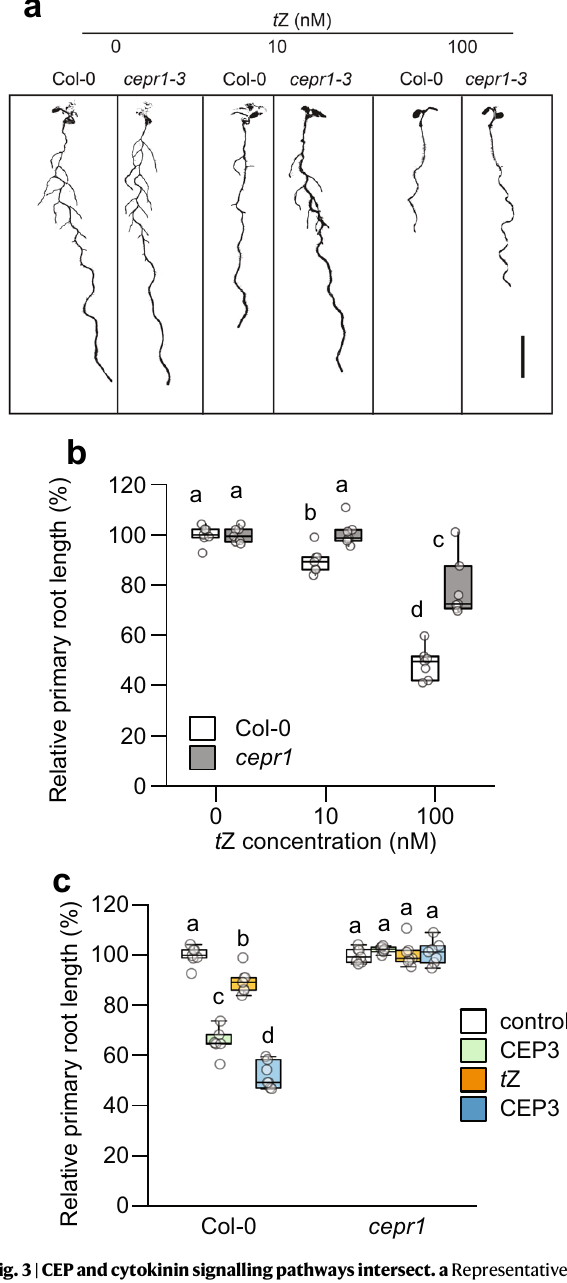
Fig.3|CEPandcytokininsignallingpathwaysintersect.a Representativeimages and b relative primary root length for Col-0 and cepr1-3 in response to increasing concentrationsof t Z(0,10,100nM)at12dg.Rootlengthexpressedasapercentage of seedlings grown on medium without t Z for each respective genotype ( n =7 plants). c CEP and t Z signalling is defective in cepr1-3 . Primary root length was measuredforCol-0and cepr1-3 plantsgrownonmediumcontainingCEP3(1 µ M), t Z (10nM),combinedCEP3and t Z,orcontrolmedium(noCEPor t Z)for12days( n =7 plants). Root length expressed as a percentage of the control plants. Letters represent signi fi cant differences (ANOVA followed by Tukey HSD test, p <0.05). Scalebar=1cm.Boxplotcentreline,median;boxlimits,upperandlowerquartiles; whiskers,1.5xinterquartilerange.SeeSupplementaryFig.6forassociatedabsolute